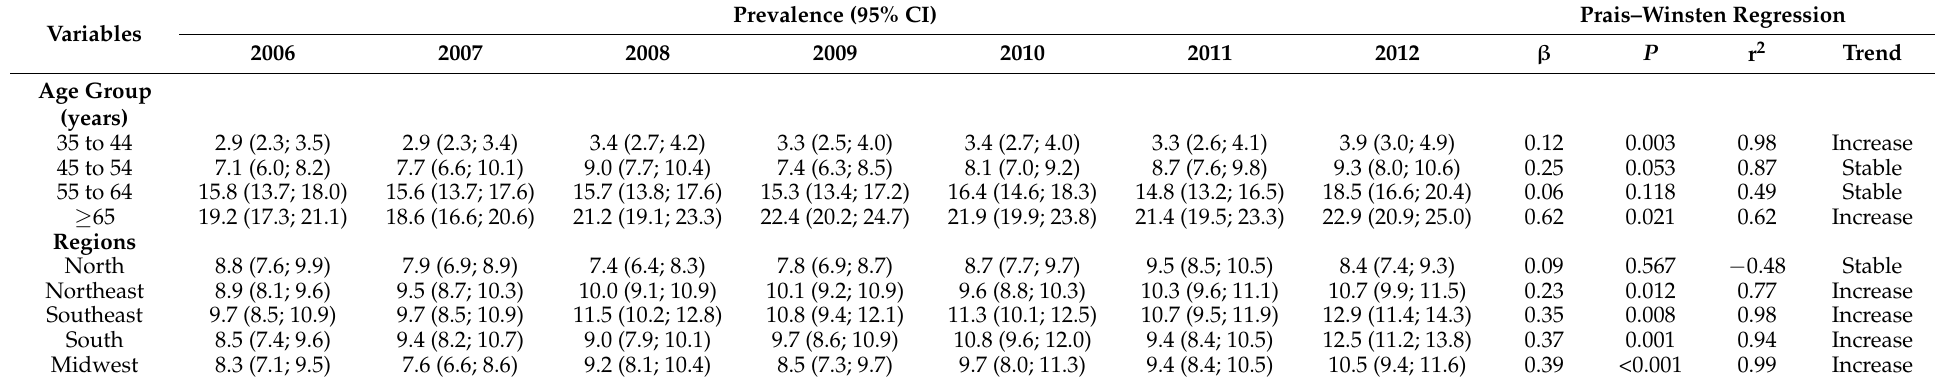
Table 2. Prevalence of diabetes in adults reporting previous medical diagnosis, stratified by age group and regions of Brazil between 2006 and 2012.